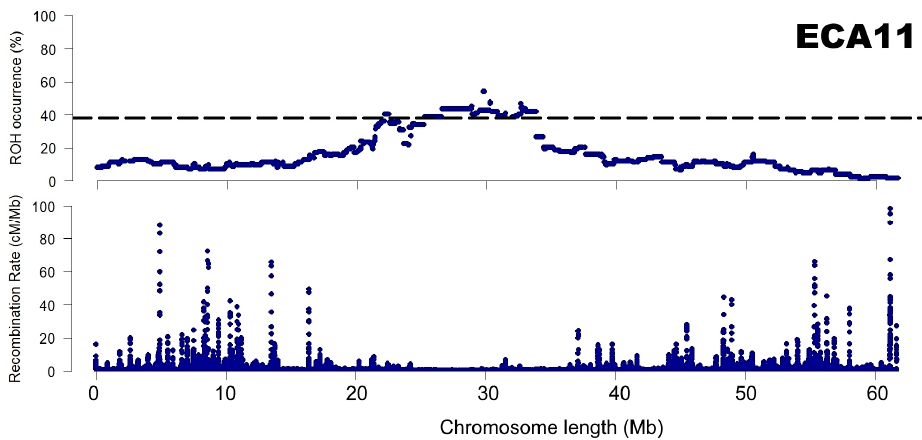
Figure 7. A relationship between recombination rate and ROH patterns presented for chromosome 11 for the Arabian breed. 11 for the Arabian